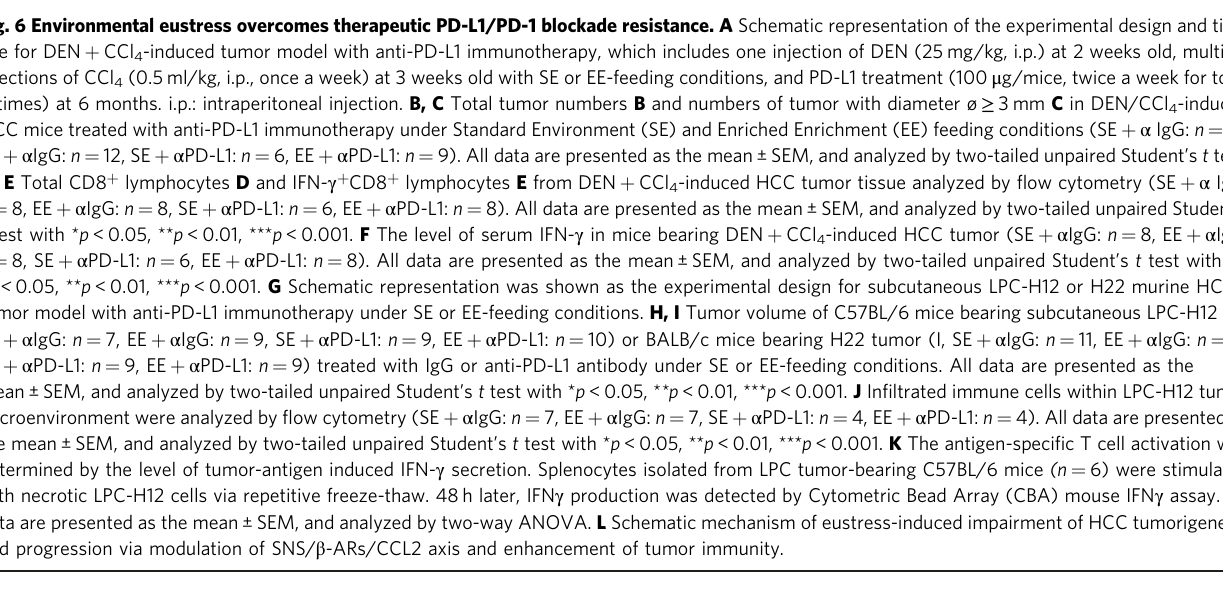
Fig. 6 Environmental eustress overcomes therapeutic PD-L1/PD-1 blockade resistance. A Schematic representation of the experimental design and time line for DEN + CCl 4 -induced tumor model with anti-PD-L1 immunotherapy, which includes one injection of DEN (25 mg/kg, i.p.) at 2 weeks old, multiple injections of CCl 4 (0.5 ml/kg, i.p., once a week) at 3 weeks old with SE or EE-feeding conditions, and PD-L1 treatment (100 μ g/mice, twice a week for